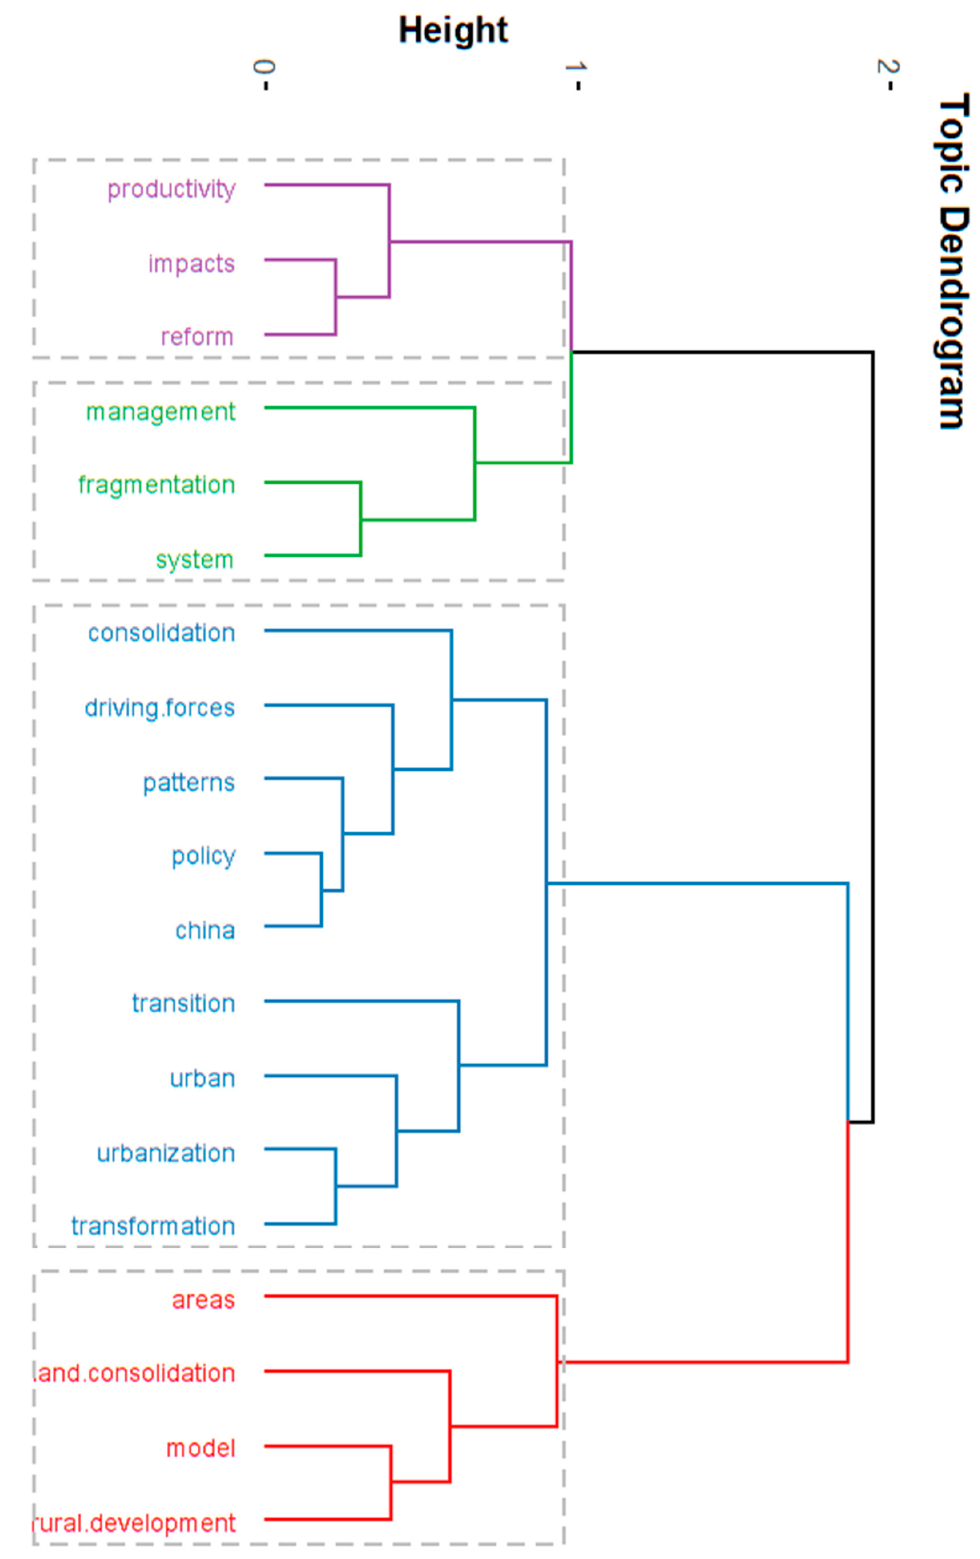
Figure 8. Tree diagram of systematic cluster analysis of keywords in land consolidation and rural revitalization from 1950 to 2021.